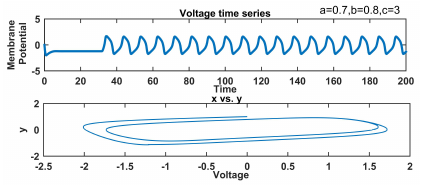
Figure 37. Responses of membrane potential and recovery variables with a = 0.7, b = 0.8, c = 3